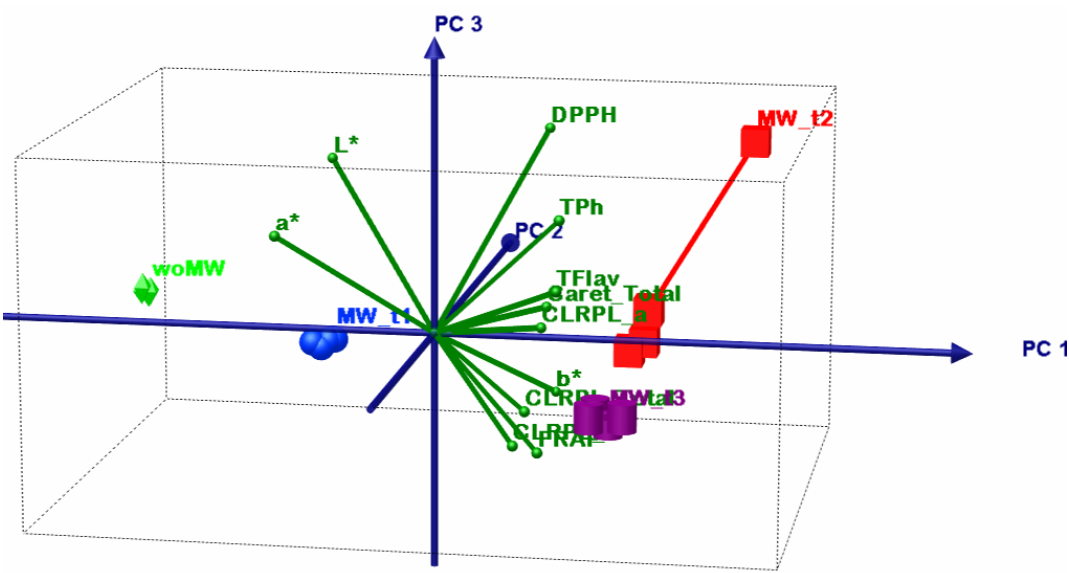
Figure 9. PCA biplot with PC1 (81.04), PC2 (15.59%), and PC3 (3.35%) principal axes.